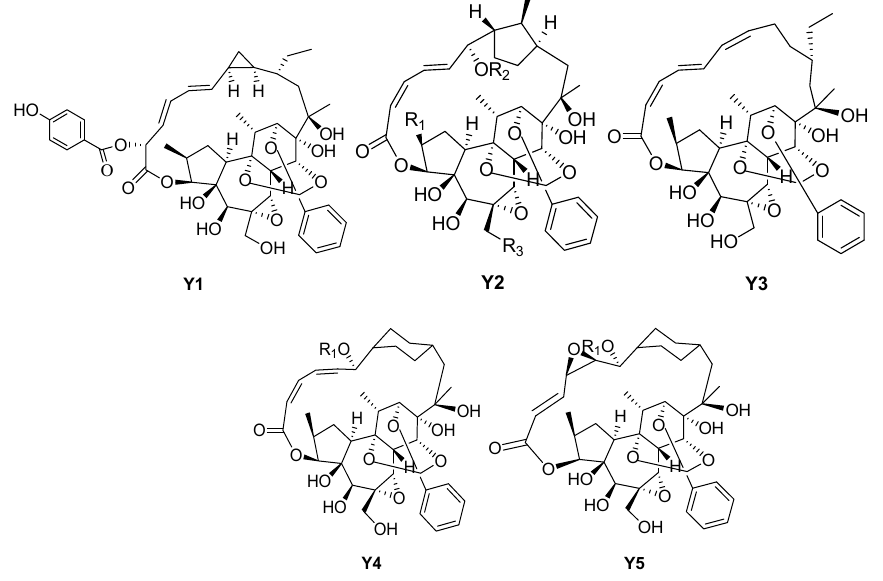
Figure 6. Five types ( Y1 – Y5 ) of rediocides skeletons. Table 6. Reported structures of rediocides skeletons.